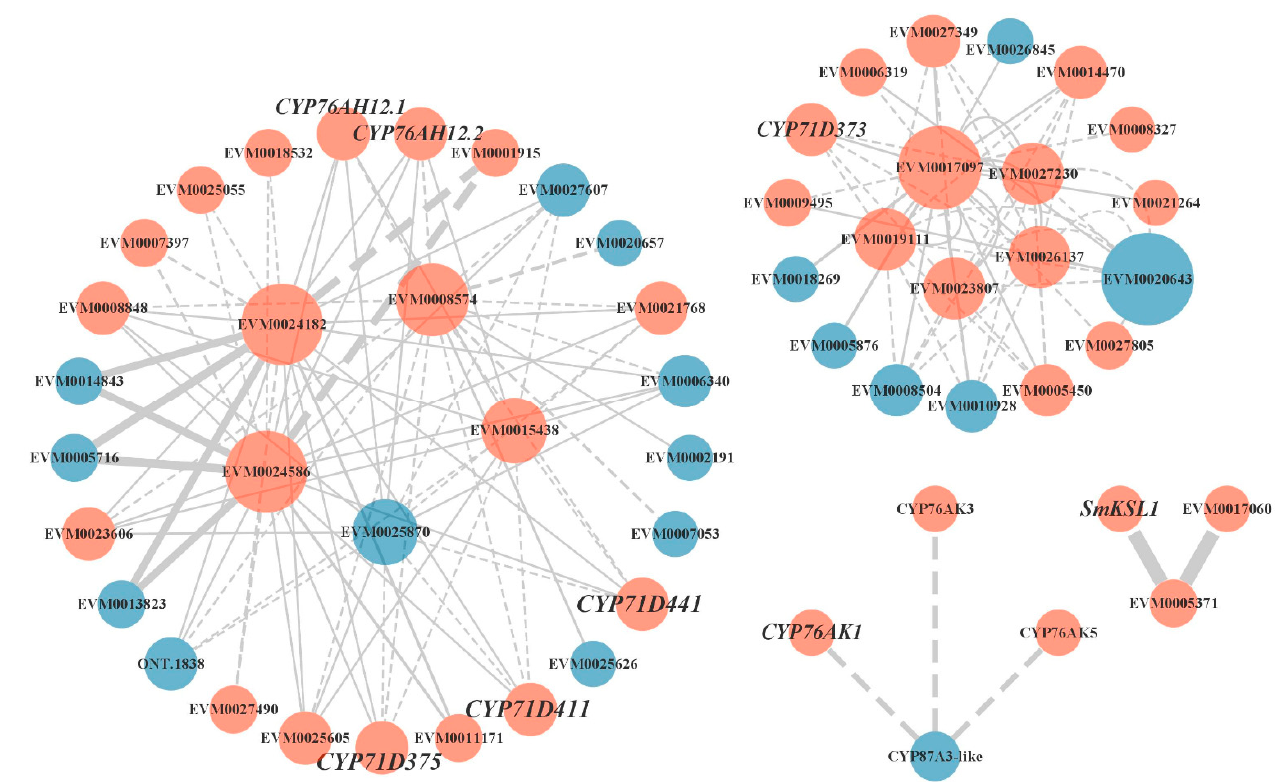
Figure 6. Protein–protein interaction network. Orange indicates that gene expression was up regulated in the red root, and blue indicates that gene expression was down regulated in red root.